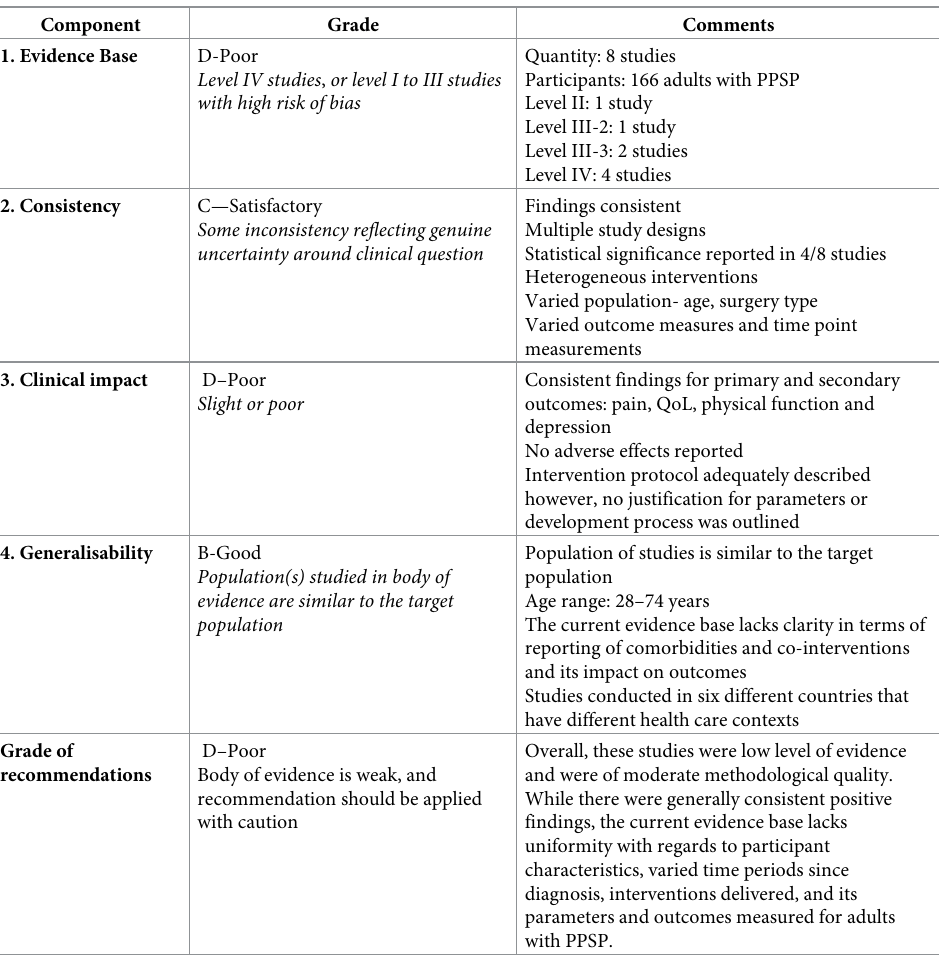
Table 5. NHMRC FORM